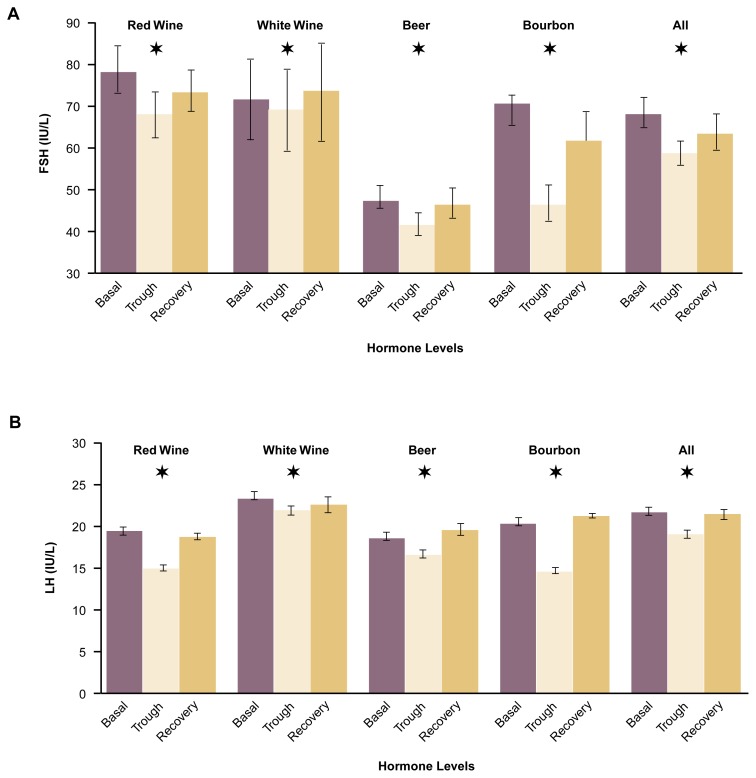
Effects of alcoholic beverage congeners on (A) follicle-stimulating hormone (FSH) and (B) luteinizing hormone (LH) levels in postmenopausal women. For 4 weeks, the women consumed congener amounts corresponding to those present in one standard drink of the beverage daily. Basal hormone levels were determined before the women began the experiment. Trough levels represent the lowest hormone levels that were detected during the 4-week administration period of alcoholic beverage congeners. Recovery levels were determined 1 week after the last ingestion of congeners. All congeners had estrogenlike effects (i.e., resulted in lower FSH and LH levels). The effects of the various congeners did not differ significantly.NOTE: The wide bars represent mean values, whereas the narrow brackets represent the standard error of the mean. A star above a bar indicates a significant difference from basal levels as determined by paired T-test (p < 0.025). The differences in baseline levels result from variations in the mean levels of the subjects in the various groups.IU/L = International units per liter.